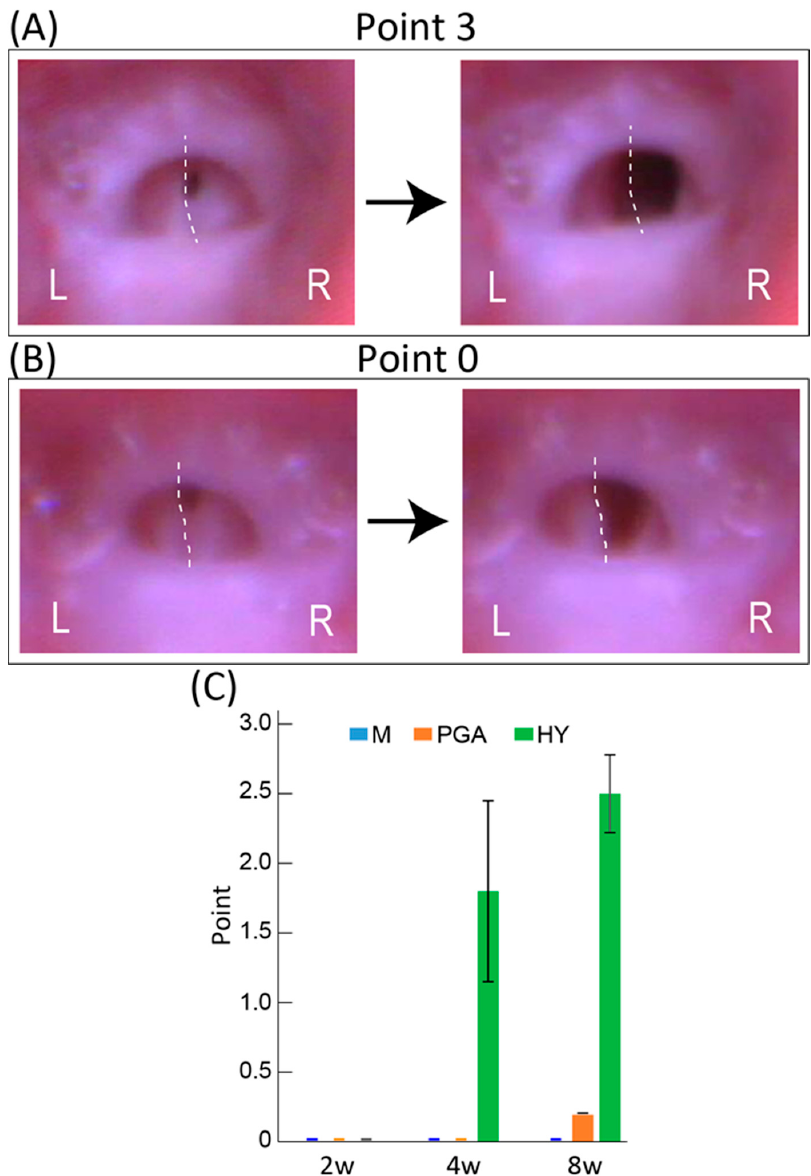
Figure 2. Typical photographs of vocal cord and evaluation of functional recovery of vocal-fold movement. ( A ) Typical photograph of vocal cord with a score of three points. ( B ) Typical photograph of vocal cord with a score of zero points. L, left side; R, right side. Dotted lines show a central situation of the left side (operated side) vocal cord. ( C ) Comparison of the functional recovery of vocal cord movement in the three groups. M, media transplanted group; PGA, PGA transplanted group; HY, hybrid transplantation (Sk-MSCs + PGA) group. The media group showed no recovery, and the PGA group showed very little recovery only at eight weeks. In contrast, the HY group showed gradual and favorable recoveries 4–8 weeks after operation. Note that the video clip of typical vocal-fold movement with the indicated 0–3 grade is available in the Supplementary Materials.